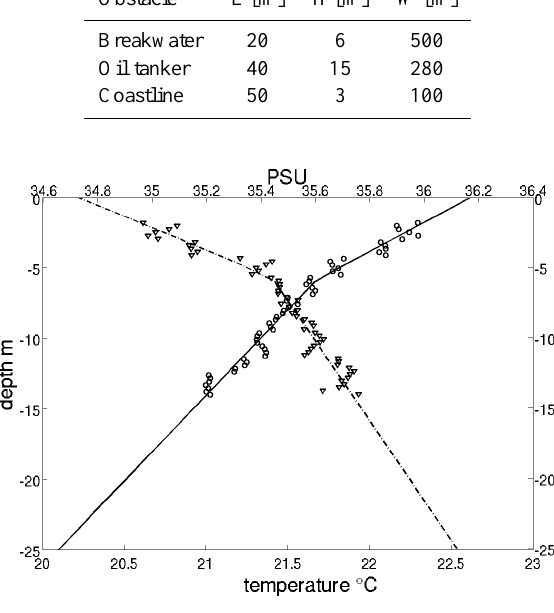
Fig. 10. Temperature and salinity profiles along the water column (June 2012). Triangles: field-data salinity values; dot–dashed line: salinity best-fit curve; circles: field-data temperature values; solid line: temperature best-fit curve;